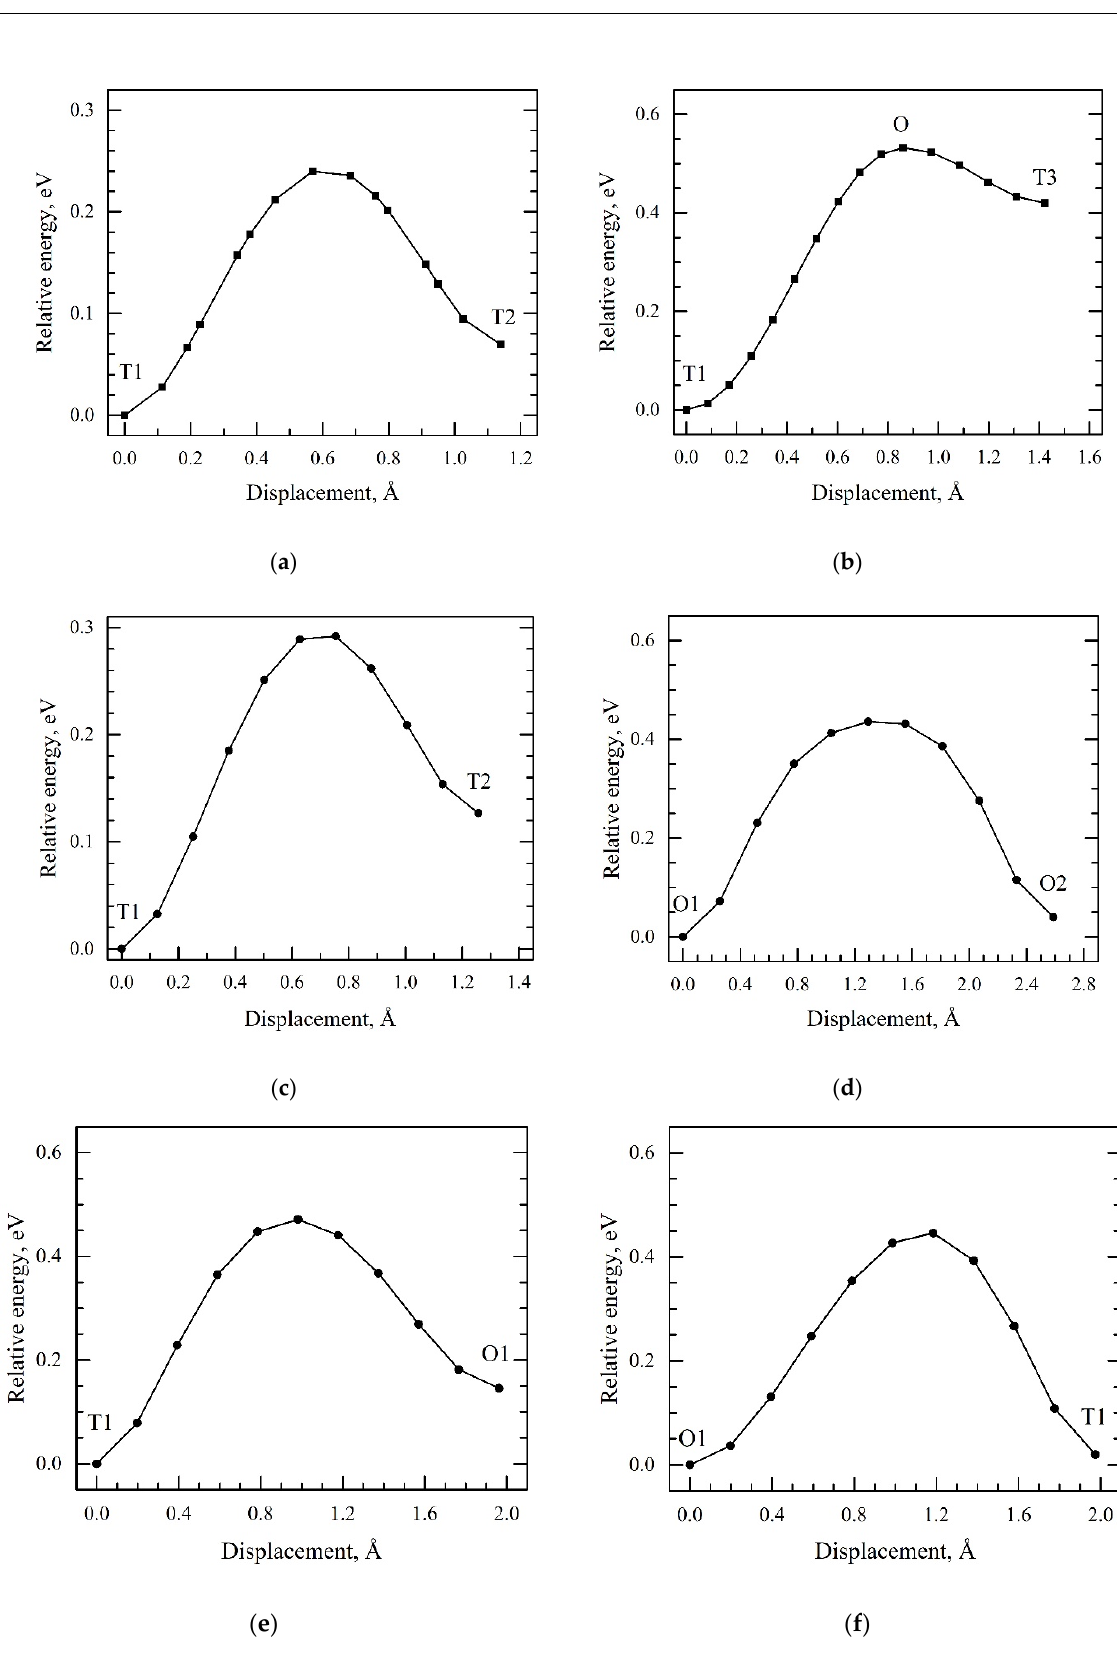
Figure 8. The minimum energy paths for hydrogen atoms along with the directions of ( a ) T1-T2 and ( b ) T1-O-T3 diffusion jumps in the BCC niobium lattice and ( c ) T1-T2, ( d ) O1-O2, ( e ) T1-O1, and ( f ) O1-T1 in the HCP zirconium lattice.